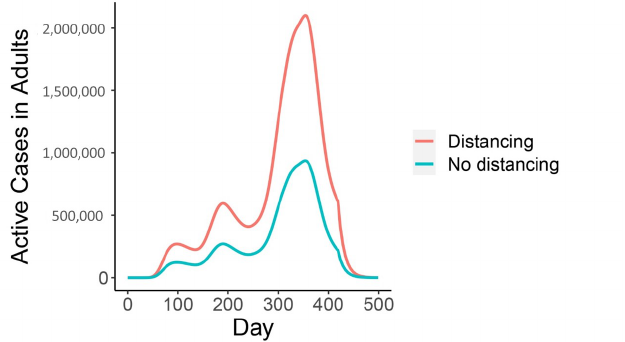
Figure 7. Social distancing which disproportionately reduces contact between children and adults from day 20 to 460 could increase the number of high-shedding cases in adults if children always develop low-shedding infections. The effect is enhanced for a larger vaccination rate. The vaccination period begins on day 360 and ends on 460 (rate of 3 million doses per day). For the “Distancing” curve, α ak = 0 from days 20-460. For the “No distancing” curve, α ak , α aa and α kk are set equal and are calibrated to the incidence data up to day 418, are set to values consistent with R 0 = 1.3 from days 418-460, and R 0 = 2.5 thereafter. Other parameters: Q ab = 0, Q am = Q kb = Q km = (cid:103) Q ab = (cid:103) Q am = (cid:103) Q kb = (cid:103) Q km = 1, and ν k =